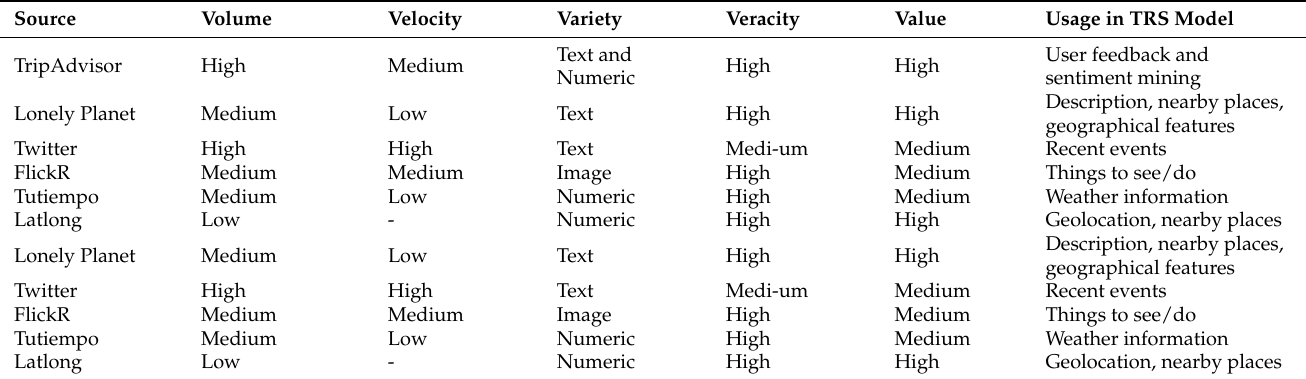
Table 3. Mapping of data sources with big data characteristics and their usage in TRS Model.